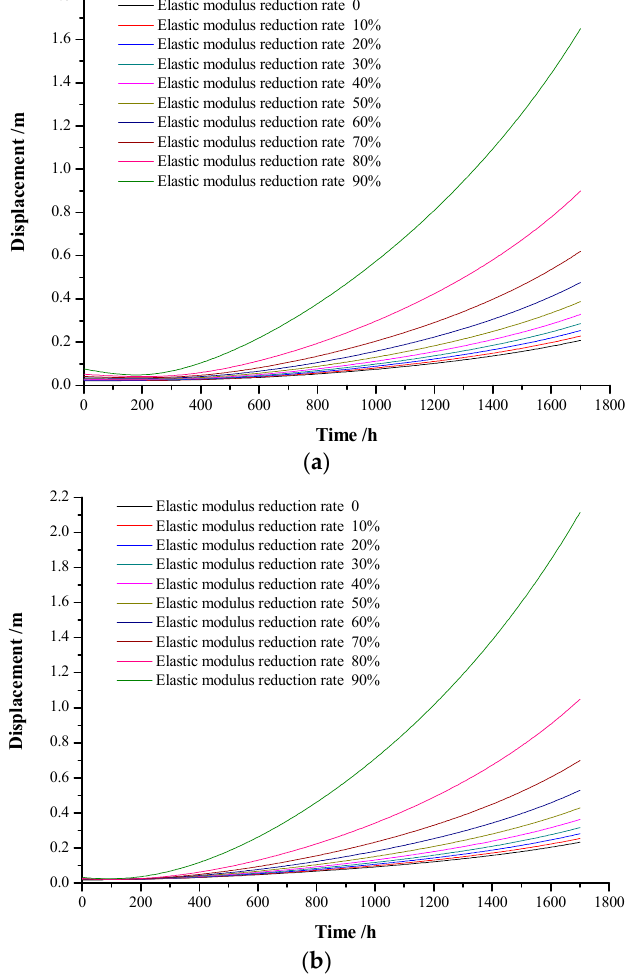
Figure 10. Variation of perimeter displacement with elastic modulus. ( a ) D3 monitoring point. ( b ) D6 monitoring point.